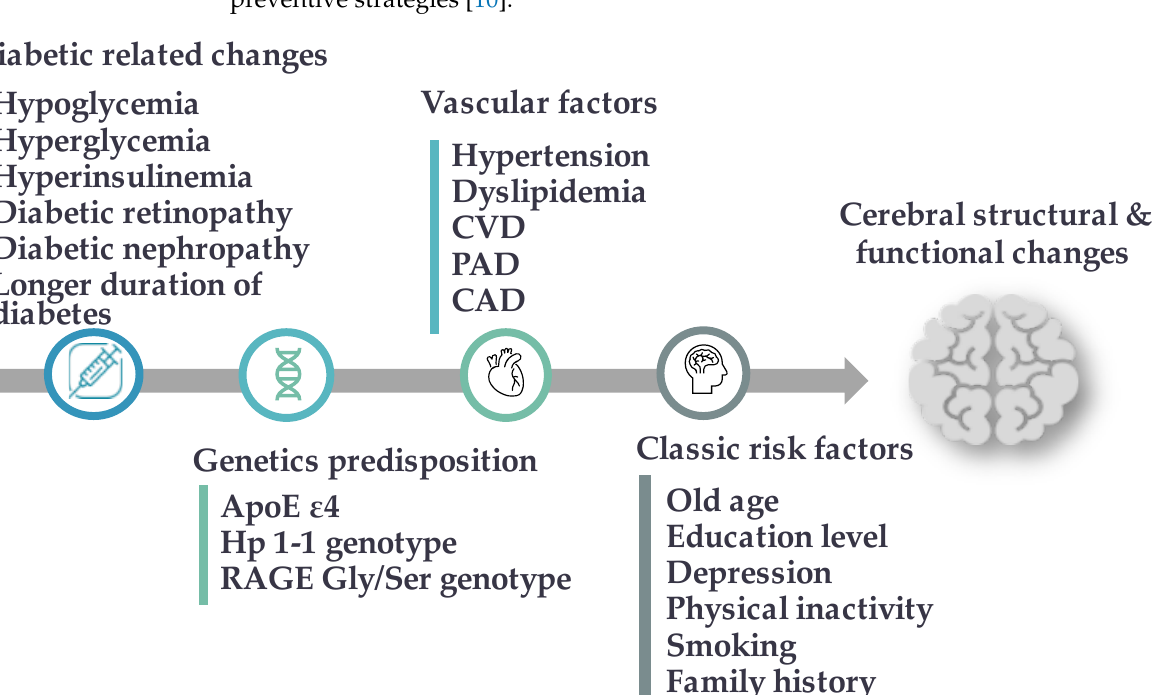
Figure 1. Potential risk factors for cognitive impairment and dementia in type 2 diabetes mellitus. Abbreviation s: CVD: cerebral vascular disease, PAD: peripheral arterial disease, CAD: coronary artery disease, Hp: Haptoglobin protein, RAGE: Receptor for advanced glycation end products.